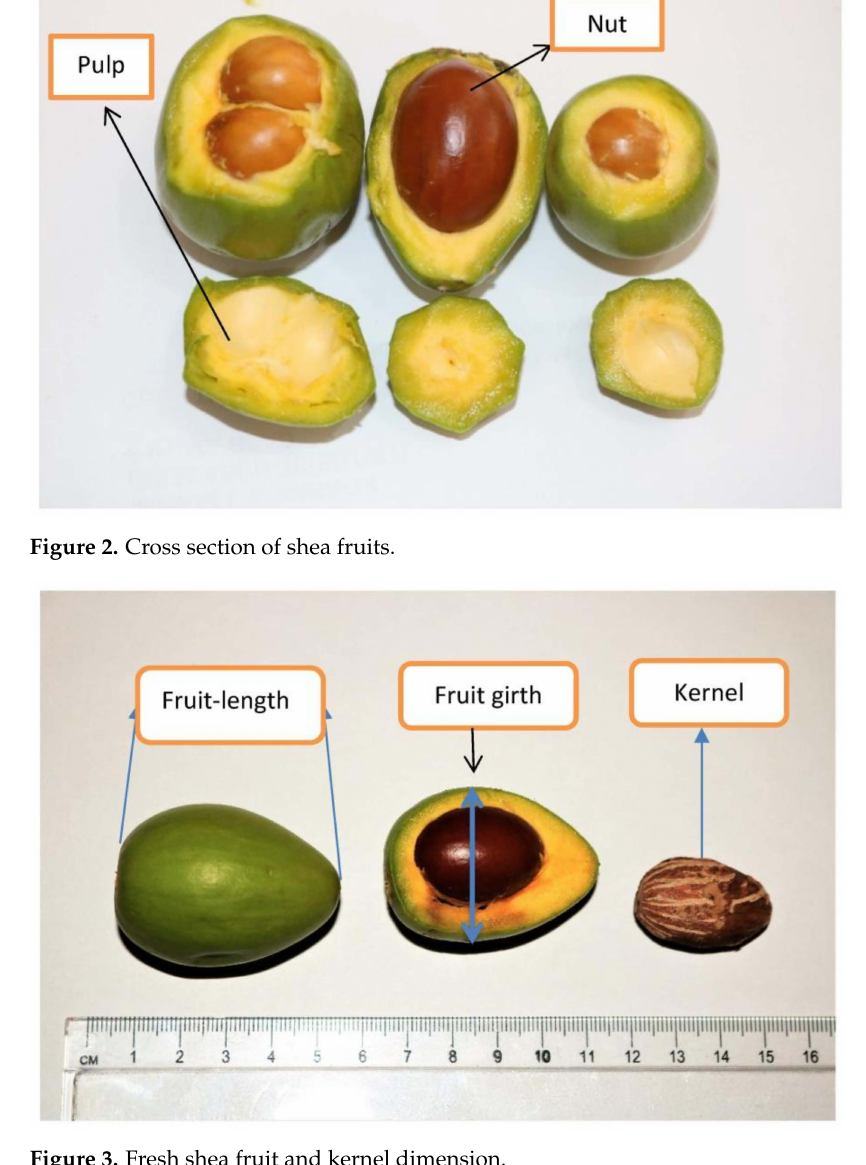
Figure 3. Fresh shea fruit and kernel